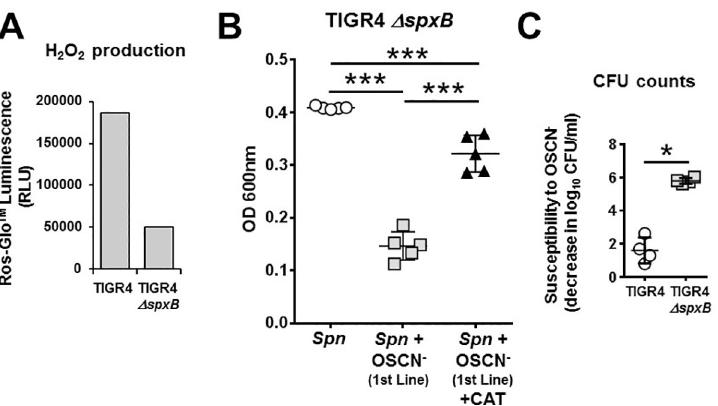
Fig 7. Pyruvate oxidase-deficiency increases susceptibility of Spn to OSCN - . (A) H 2 O 2 generation was quantitated in wild-type and spxB -deficient ( Δ spxB ) TIGR4 Spn strains using the Ros-GLo TM luminescence H 2 O 2 quantitation kit. Mean, n = 2. (B) OSCN — mediated (1st line ™ ) killing of the TIGR4 Δ spxB Spn strain was measured by the microplate- based growth assay in presence or absence of catalase (n = 5). Each symbol represents a separate, individual experiment, mean+/-S.E.M. is shown. One-way ANOVA, Tukey’s multiple comparison test. (C) Killing by OSCN - generated via 1st line ™ of wild-type and TIGR4 Δ spxB Spn strains was compared at 6 hrs via CFU counting (n = 4) and “susceptibility to OSCN - ”was calculated as the decrease in log 10 CFU upon exposure to OSCN - . Each symbol represents a separate, individual experiment, mean+/-S.E.M. is shown. Mann-Whitney’s test. Each experiment was done in biological triplicates and each biological replicate was tested in technical triplicates. ��� , p < 0.001; � , p < 0.05; ns, not significant. RLU, relative luminescence unit; CAT,